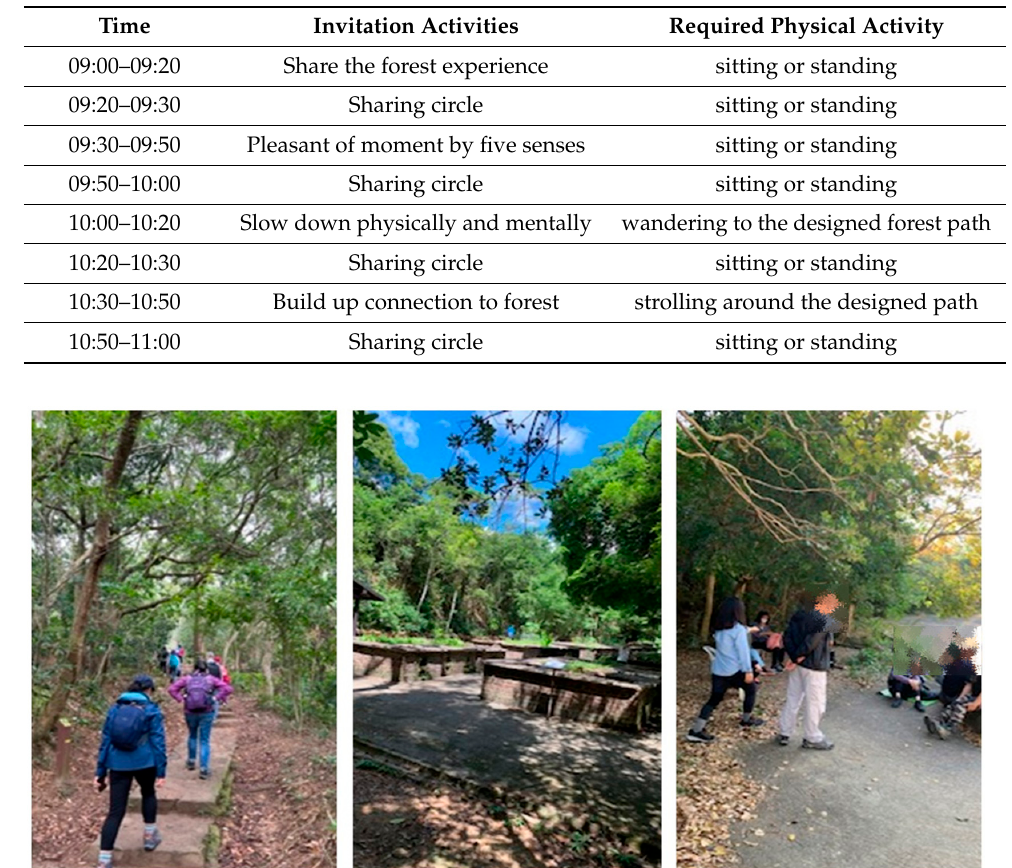
Figure 1. The scene of the designated path and the activities of the forest walk.